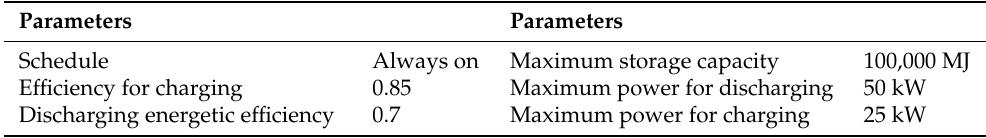
Table 4. Parameters of reference ESS